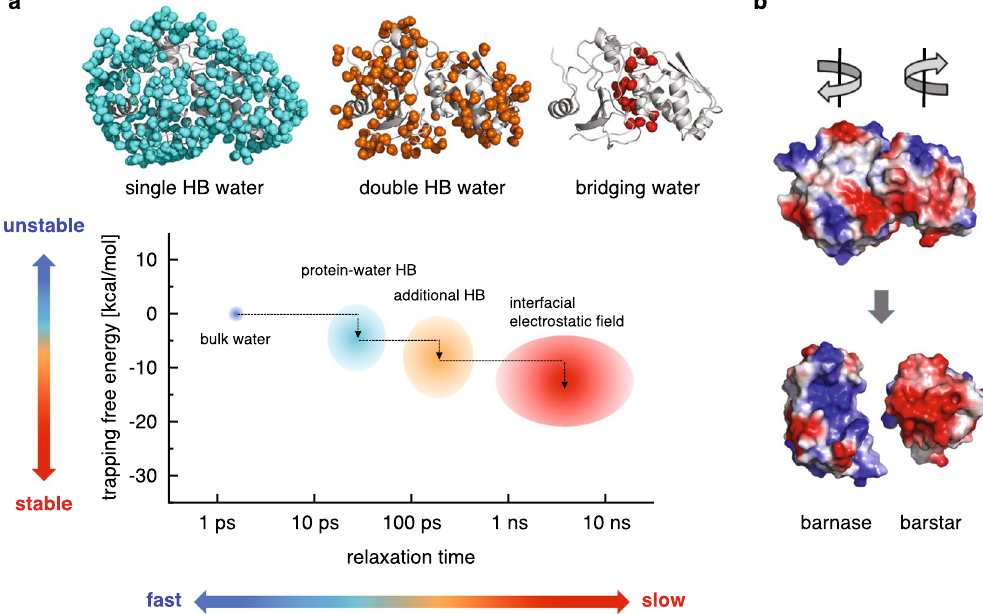
Figure 6. ( a ) Schematic representation of the thermodynamic–dynamic relationship diagram of hydration water. Here, the lower panel from Fig. 5 is schematically redrawn for single HB water (cyan), double HB water (orange), and bridging water (red), along with the position for the bulk water (blue). ( b ) Protein surfaces color- coded with the charge distribution (blue and red for positively and negatively charged regions,